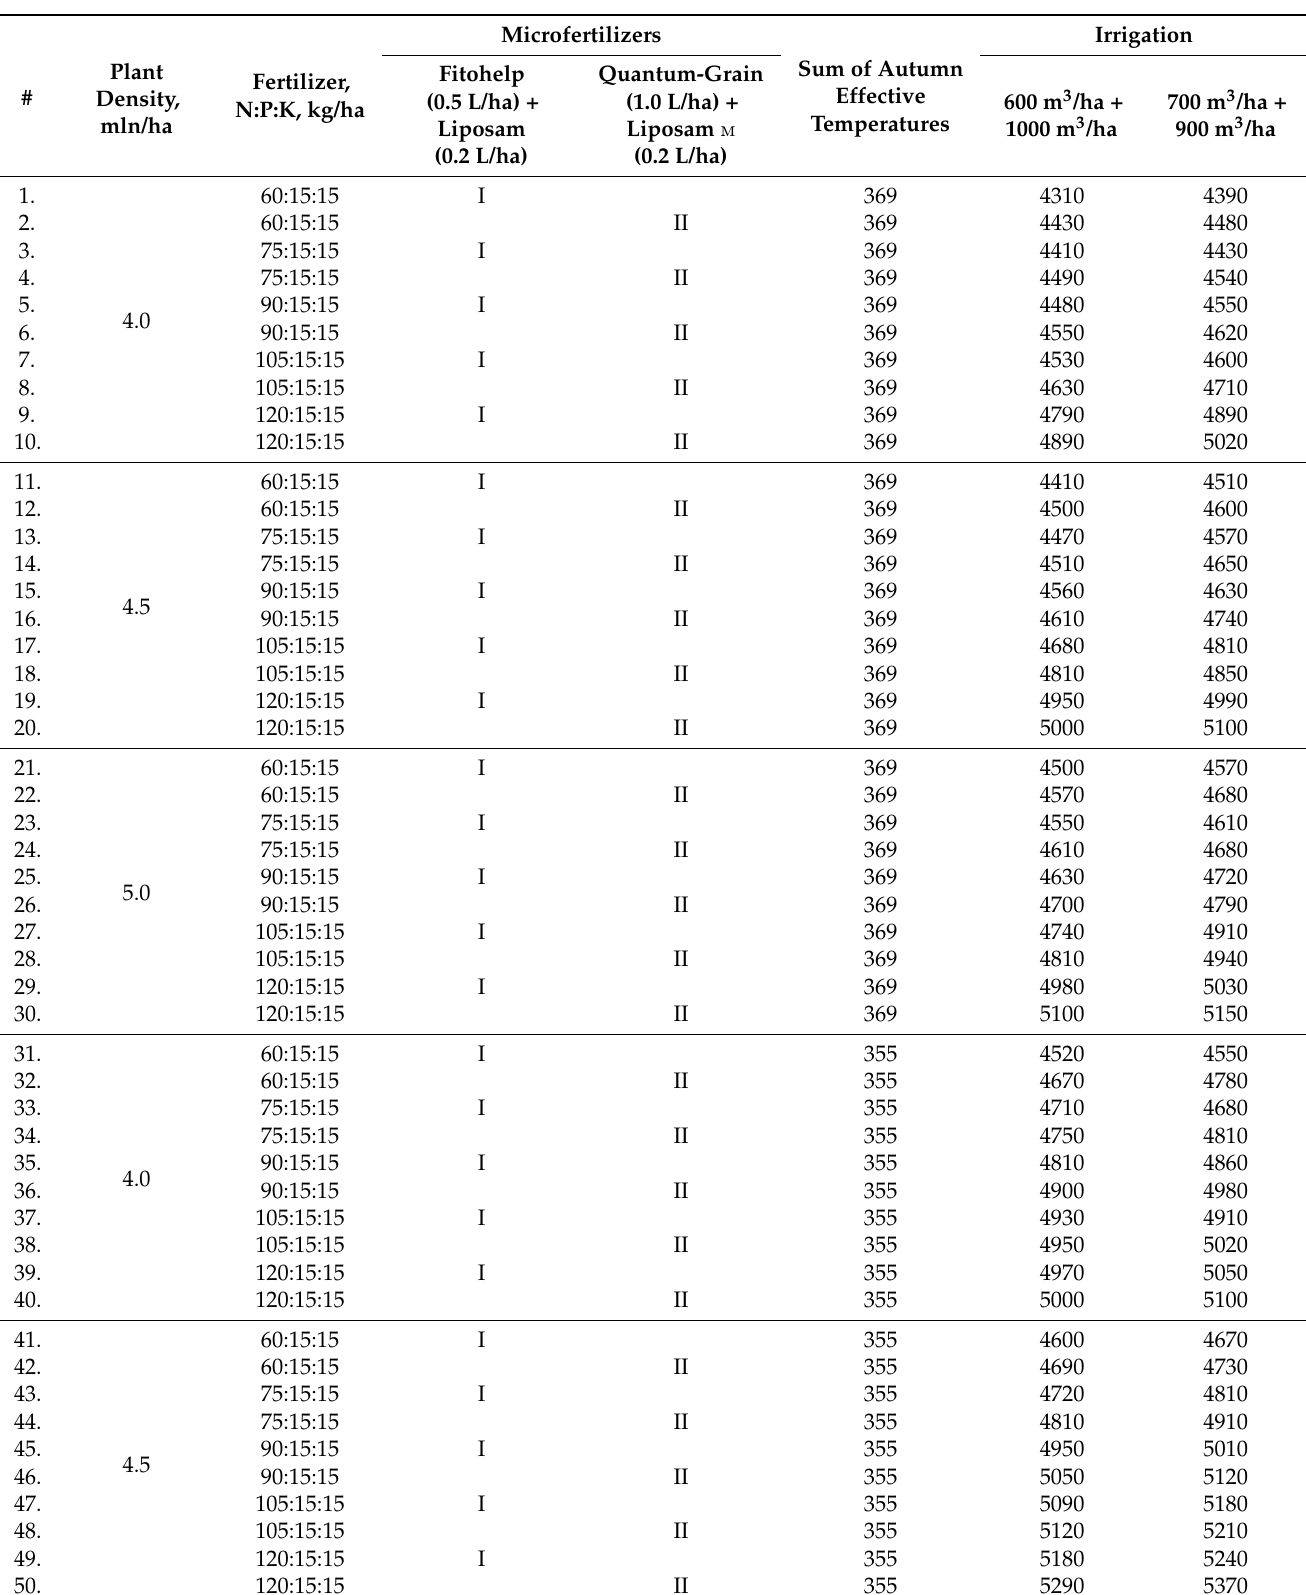
Table A1. Yields, kg/ha (preceding